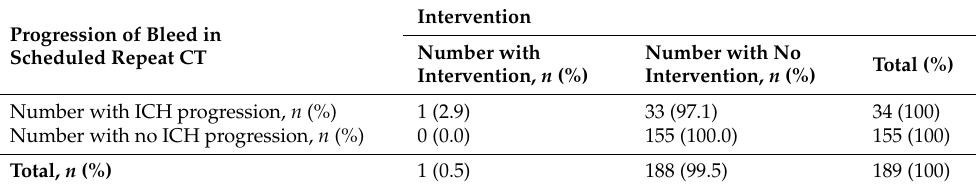
Table 3. Progression of ICH in scheduled repeat CT in relation to intervention.